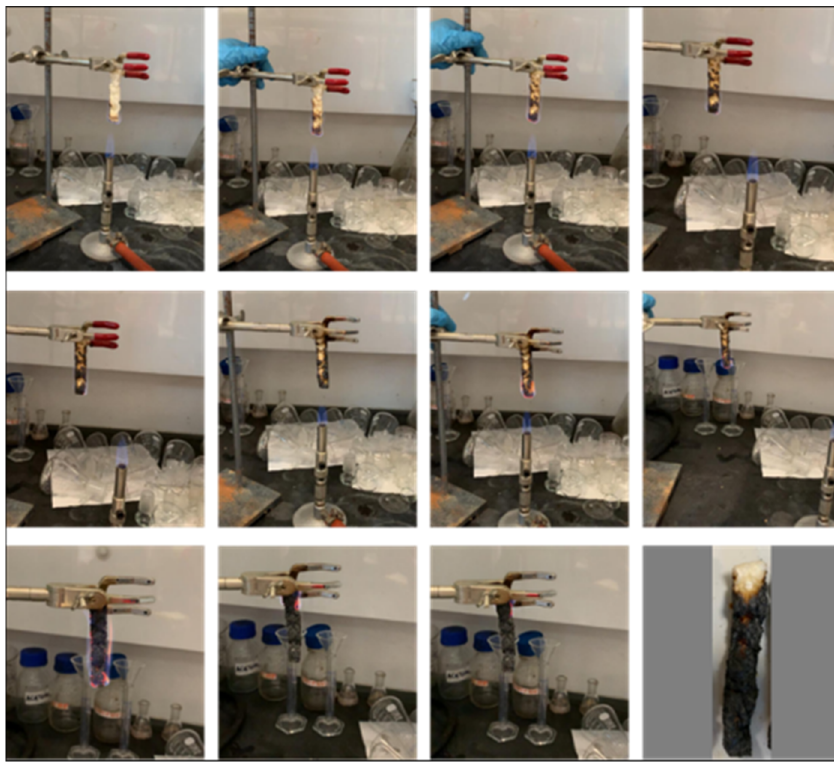
Figure 8. The puffed rice insulation sample phases under the UL94 V Fire test.